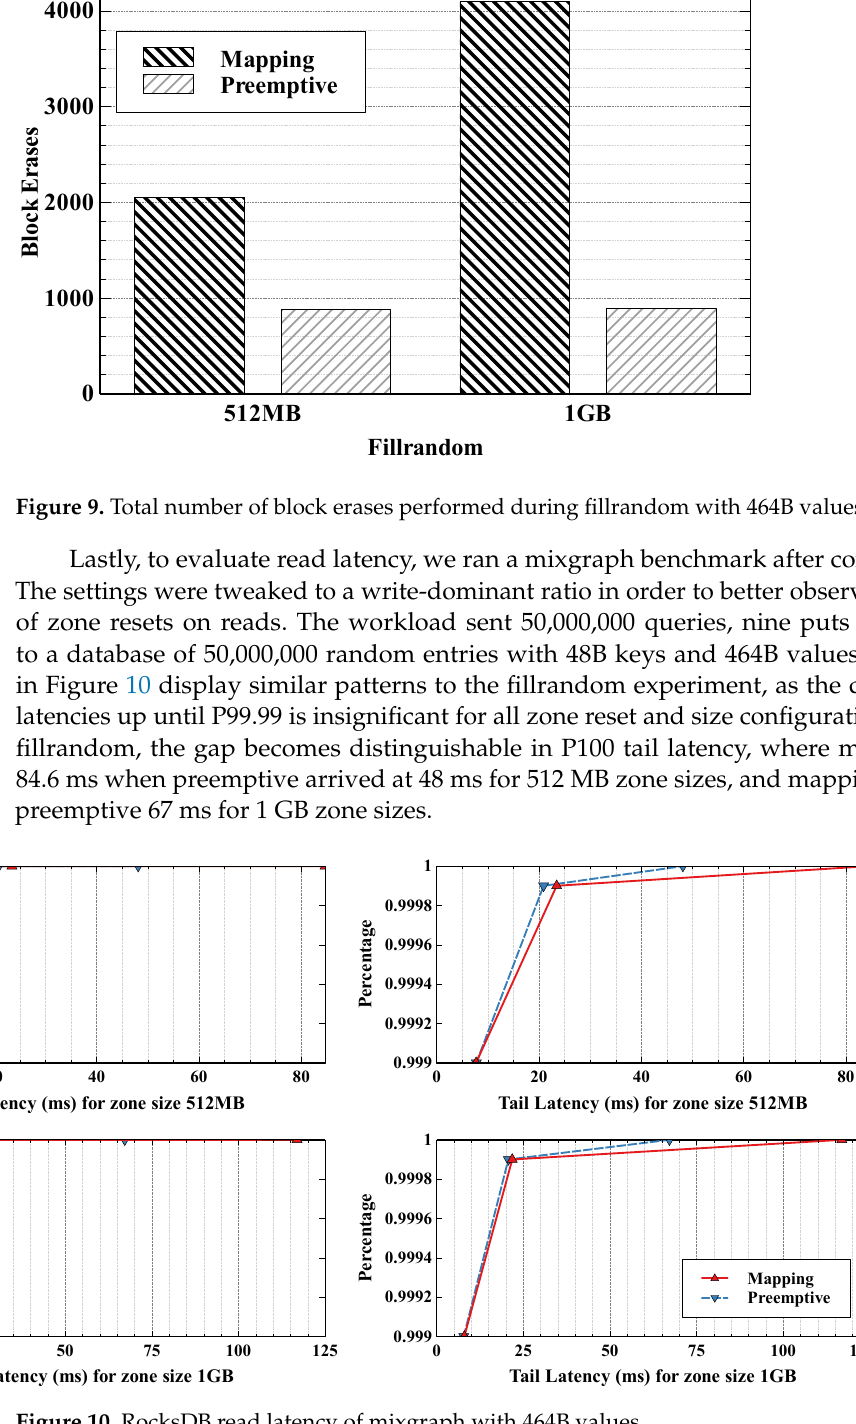
Figure 10. RocksDB read latency of mixgraph with 464B